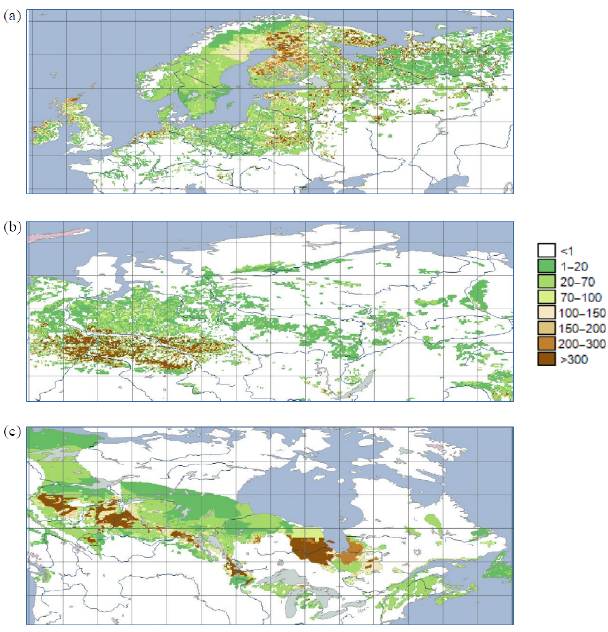
Figure 3. The conductivity-dependent estimate of the poten- tial carbon stocks in northern peatlands per area of a grid cell ( × 10 9 g Ckm − 2 ) in Europe (a) , western Siberia (b) , and Canada (c)